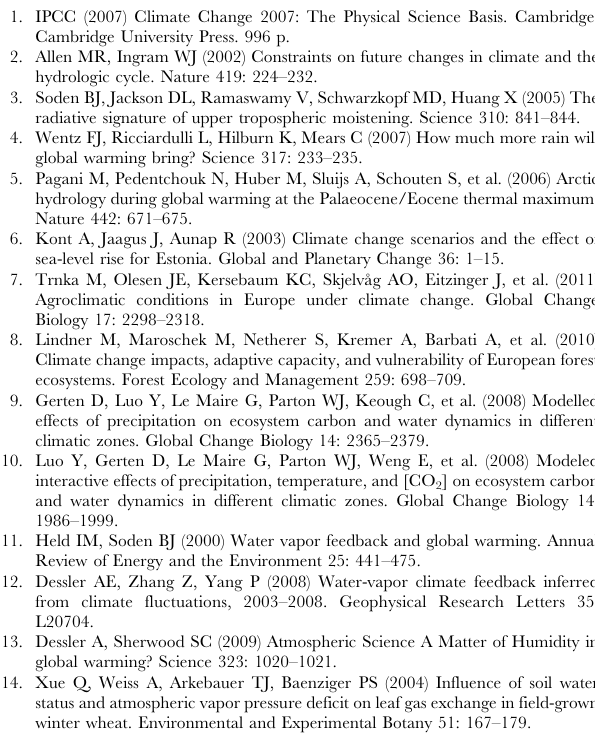
Table S1 Growth characteristics (arithmetic mean ± standard error) of hybrid aspens in control (C1, C2, C4) and humidified (H1, H2, H4) plots during the study period. Table S2 First and second order results of the